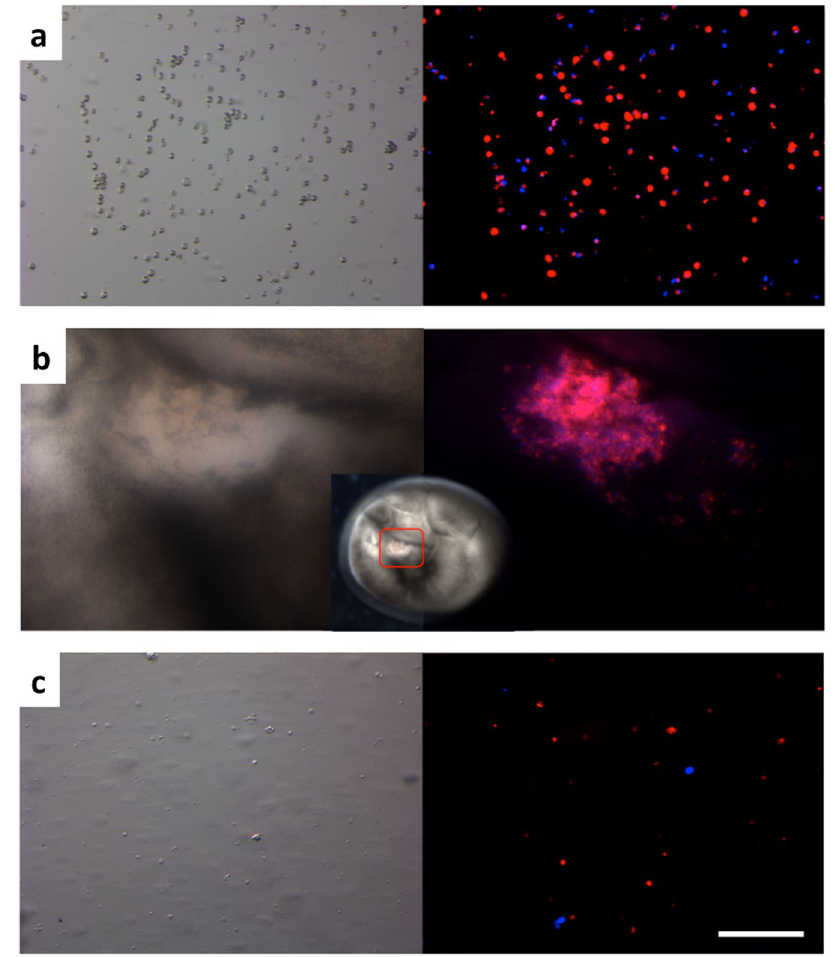
Figure 1. In vivo fluorescence analysis of fresh dissociated fin cells from Russian sturgeon. The left column represents bright field images while the right column shows the merging of UV and DsRED images. ( a ) Freshly dissociated fin cells before transplantation. The red color indicates the fin cell plasma membrane while the blue color indicates the released fin cell nuclei in cells with altered or striped off plasma membranes. ( b ) Visualization of the multiple fin cells inside the 8-cell stage developing Russian sturgeon mNT (corresponding to 6 hpa). The red color indicates the fin cell plasma membrane (intact or striped off) and the violet color indicates existence of released nuclei (blue color) that overlapped with the fin cell plasma membrane (red color). ( c ) Nuclei appeared after smashing the 8-cell stage Russian sturgeon mNT. Scale bar corresponds to 200 μ